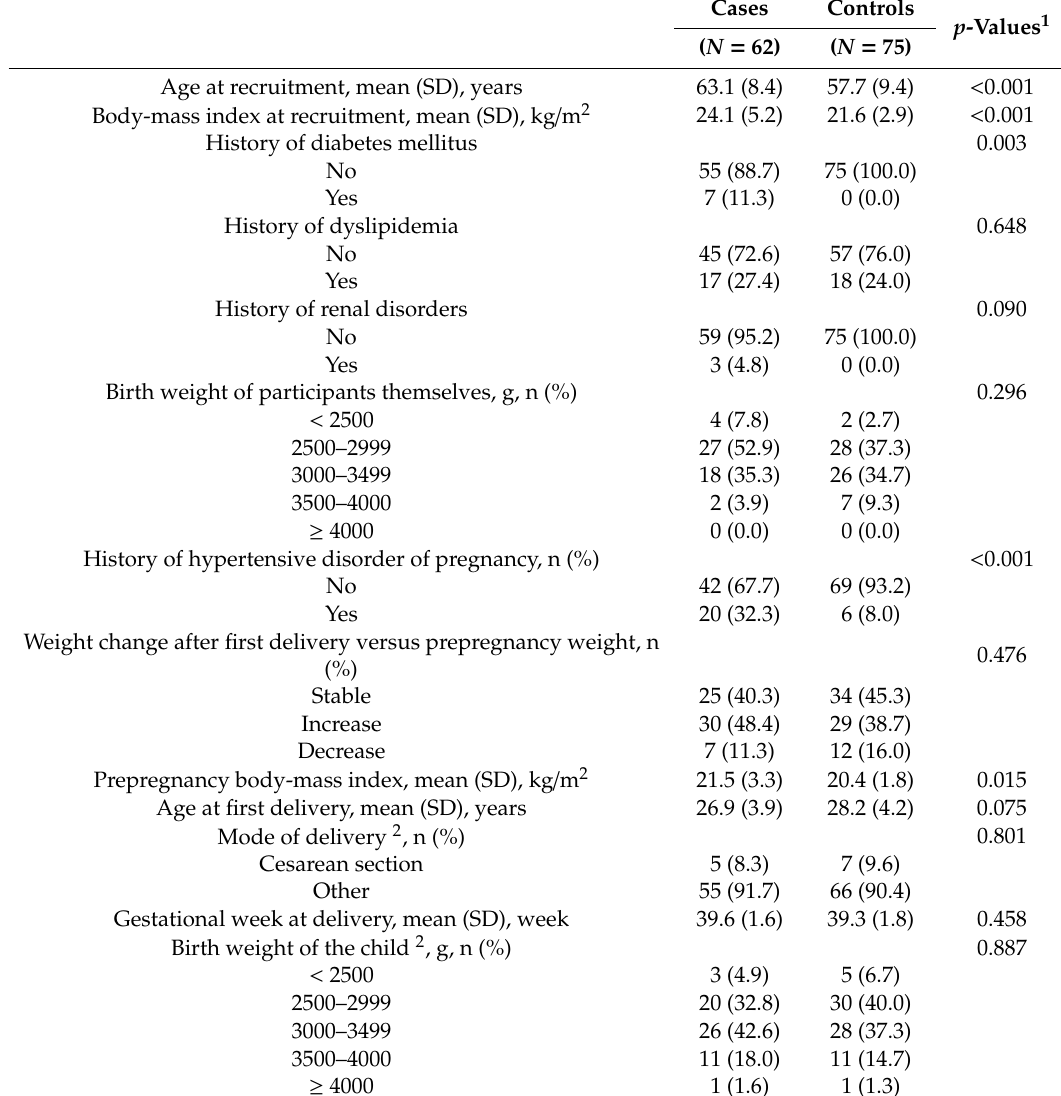
Table 1. Characteristics of participants (N =